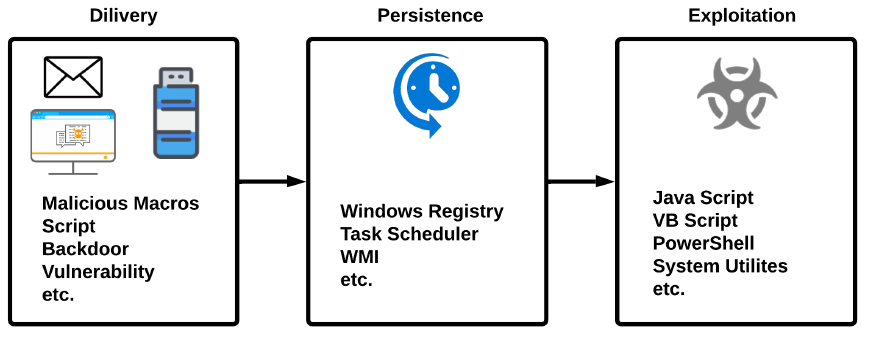
Figure 4. Life cycle of fileless